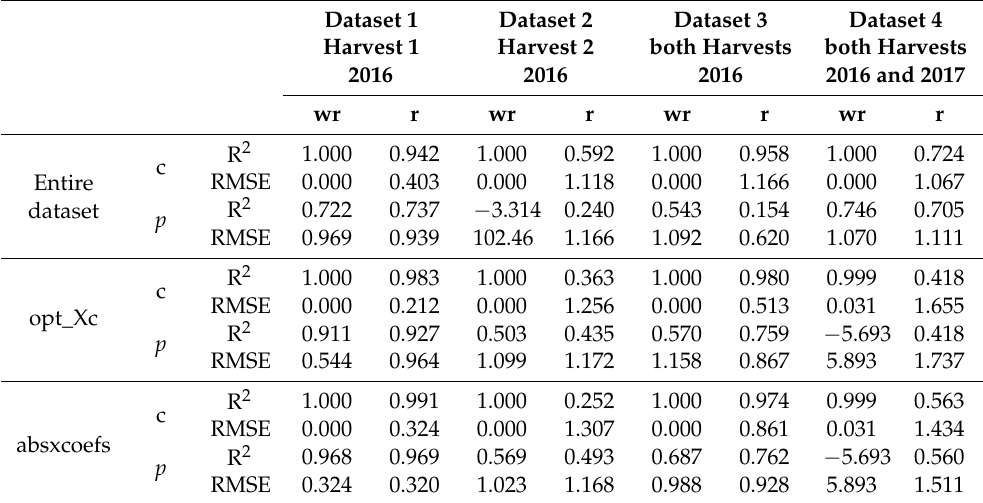
Table 5. Comparison of the performance of MLR models for TSS prediction with and without regularization of the spectra by the LassoCV